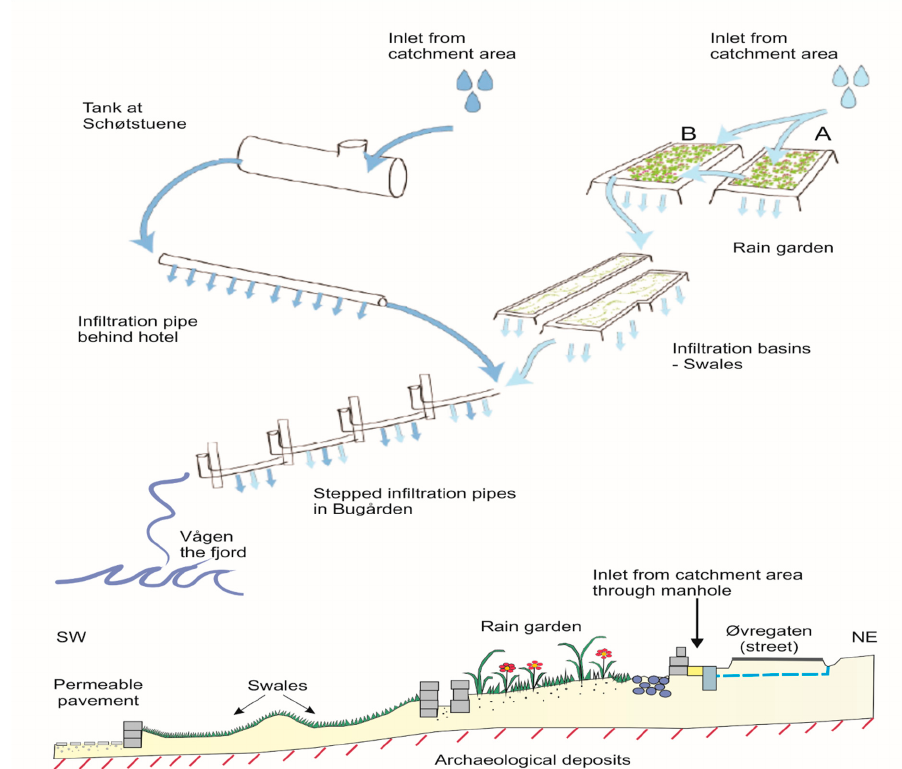
Figure 2. Top: Sketch of the infiltration system at Bryggen (Drawing: Multiconsult AS). Bottom: Cross section of rain garden, swale, and permeable pavement (modified from de Beer & Boogaard [40]).